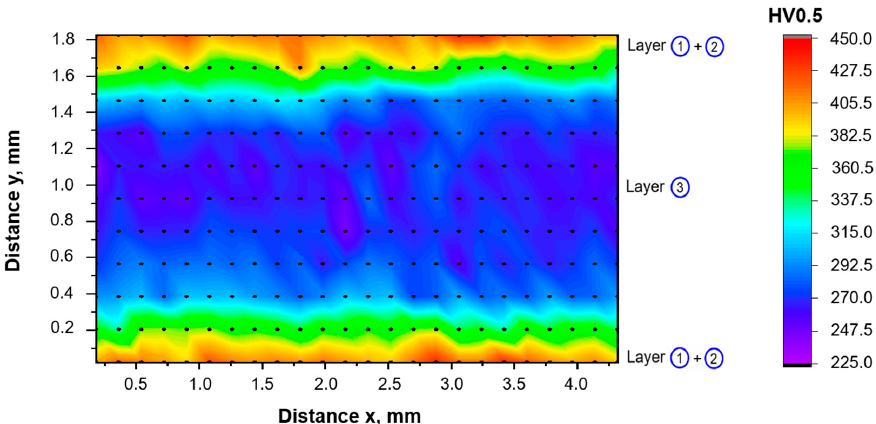
Figure 7. Hardness map showing the hardness distribution in the cross-section of a SMAT processed SS 316L specimen. Each black dot represents the position of a single measurement. The different microstructural layers characterized by TEM measurements (cf. Figure 6) are also marked. Figure 8 highlights the behavior under quasi-static tensile loading by depicting rep-